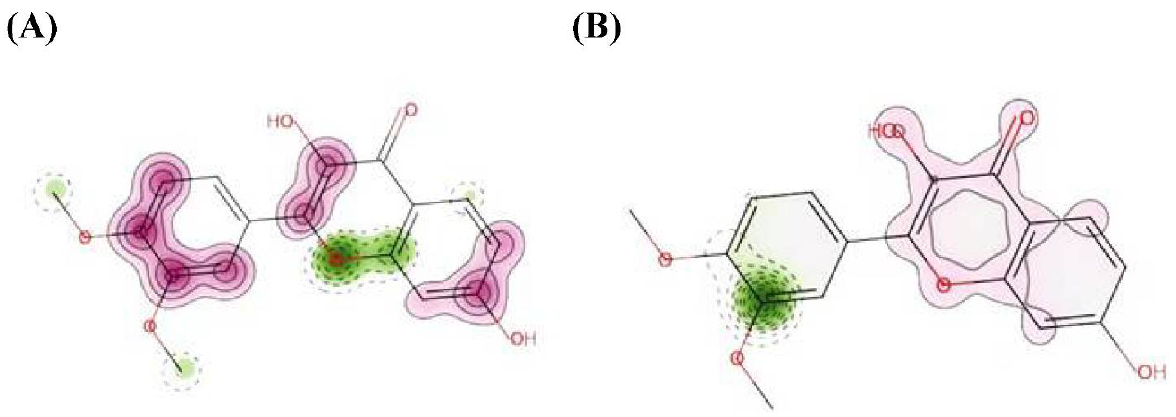
Figure 9. Map of skin sensitization of isolated flavone obtained from pred-skin. ( A ) h-CLAT ( B ) KeratinoSens. The positive and negative contributions of individual atoms or pieces to the skin sensitization have been identified. The bright pink hue shows that an atom and fragment have made a detrimental impact on skin sensitization.